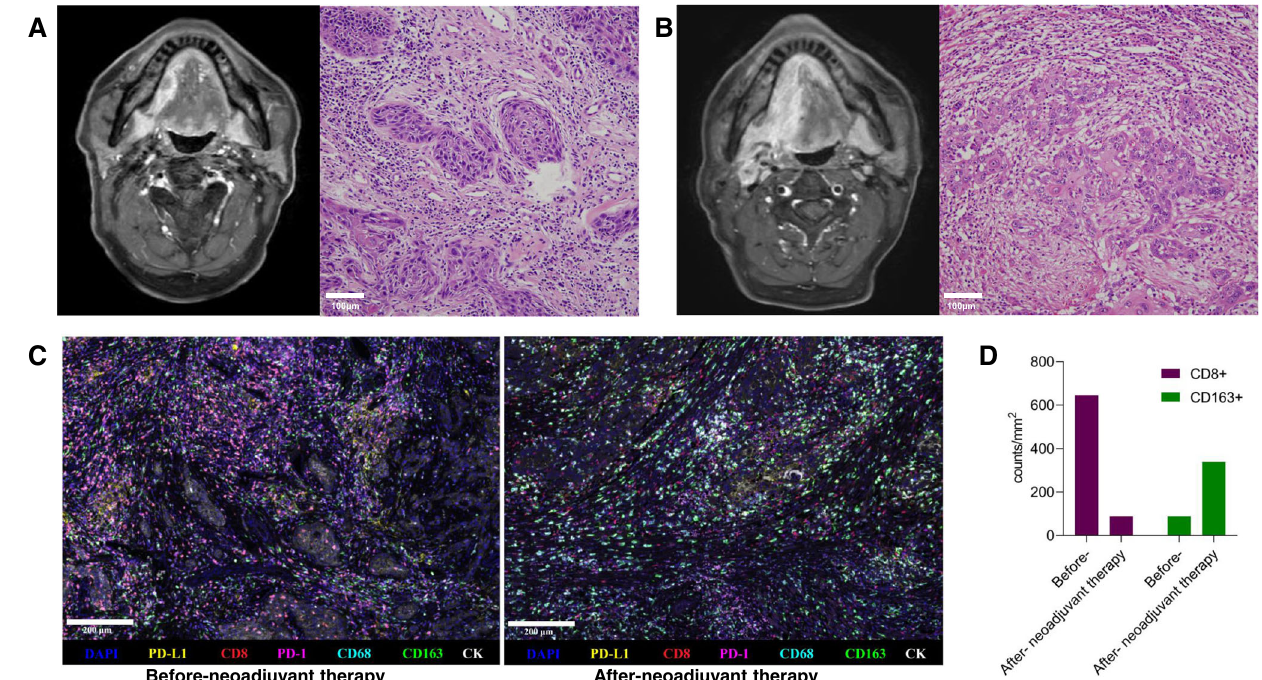
Fig. 4 | Features of the hyperprogressive disease. In patient No. 14, who showed hyperprogressive disease: radiographic and H&E staining images before ( A ) and after ( B ) neoadjuvant therapy. C Multiplex immuno fl uorescence images of the tumour site before and after neoadjuvant therapy. Primary antibodies targeting CD163, CD68, PD-1, CD8, PD-L1, and Pan-CK were used. Nuclei acids were stained withDAPI. D Comparisonof fl uorescenceintensityforCD8+andCD163+cells.After